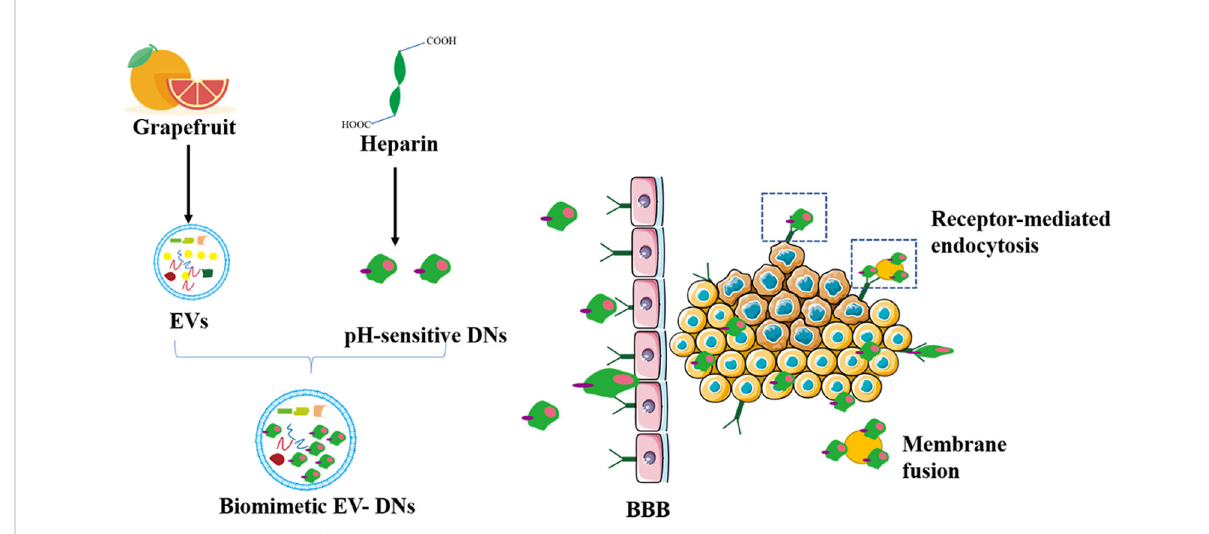
FIGURE 4 Grapefruit EVs-doxorubicin loaded nanoparticles for glioma treatment. The pH-sensitive DNs as a carrier were devised to incorporate to the surface of grapefruit EVs for the treatment of glioma by natural biomacromolecule heparin. DN, doxorubicin-loaded heparin-based nanoparticles; BBB, blood brain